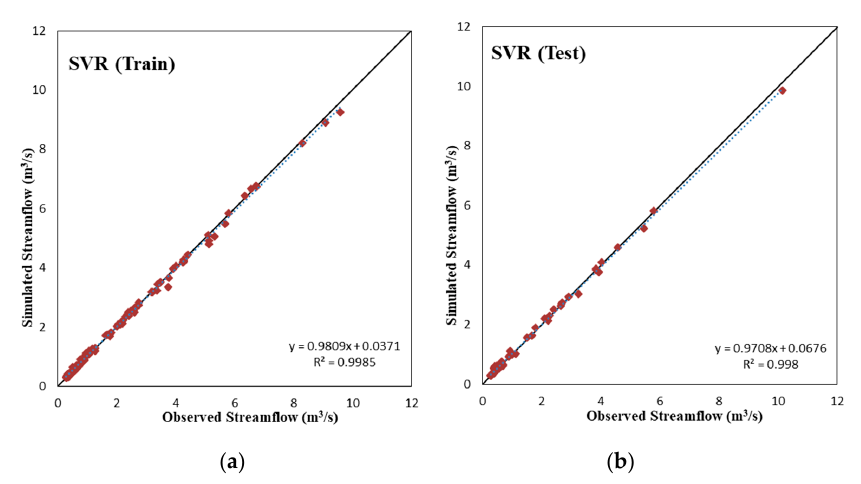
Figure 7. Support vector regression (SVR) scatter plots: ( a ) train; ( b ) test.